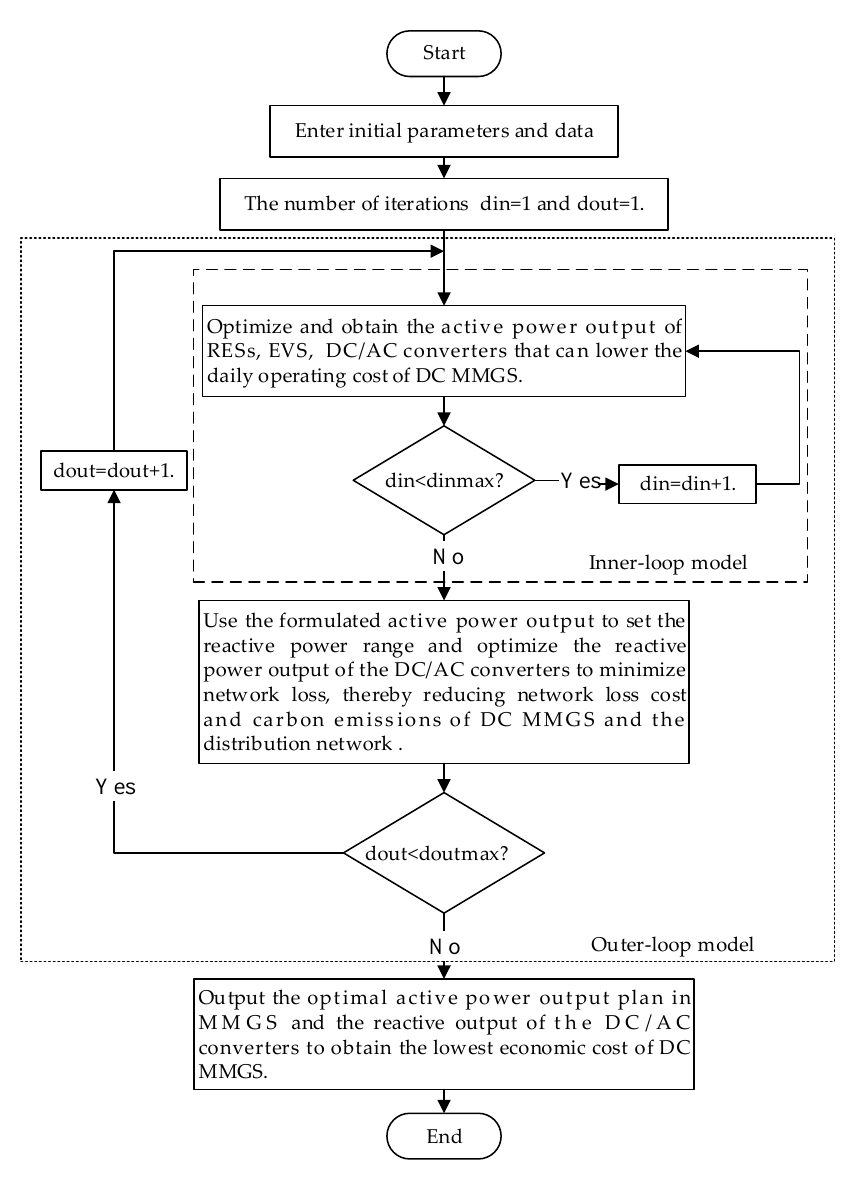
Figure 4. Process of th e c ooperative multi-objective optimization.